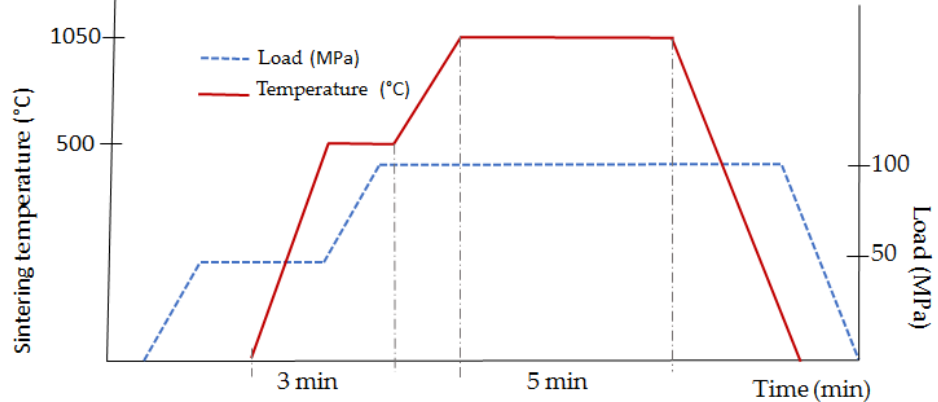
Figure 4. Schematic course of the consolidation process of the WC-Co/diamond composite.